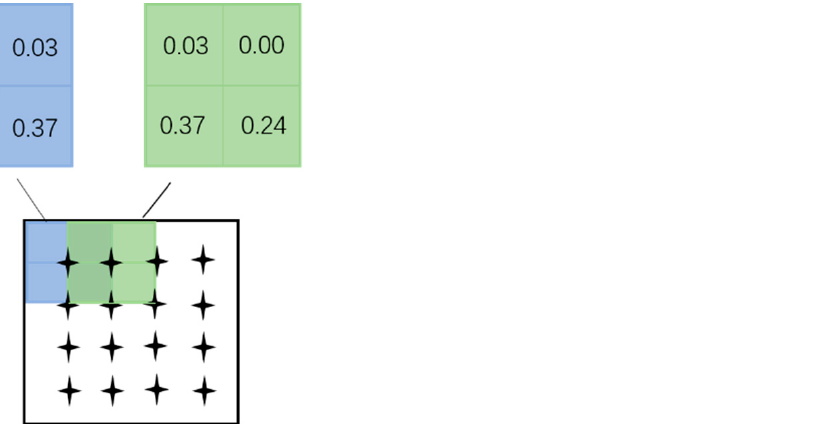
Figure 3. The blue and green squares are two regions divided by R-MAC [25] in a channel-wise feature map. The distribution differs in these two regions.